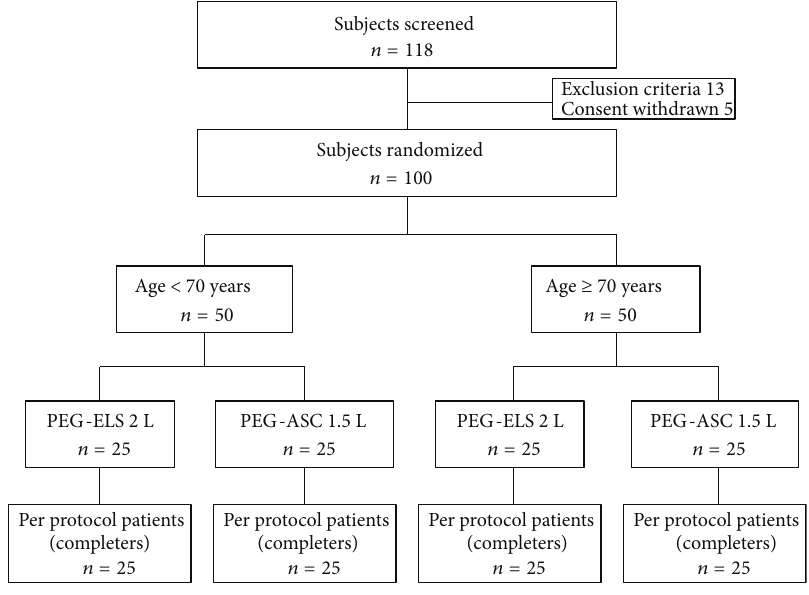
Figure 2: Patient